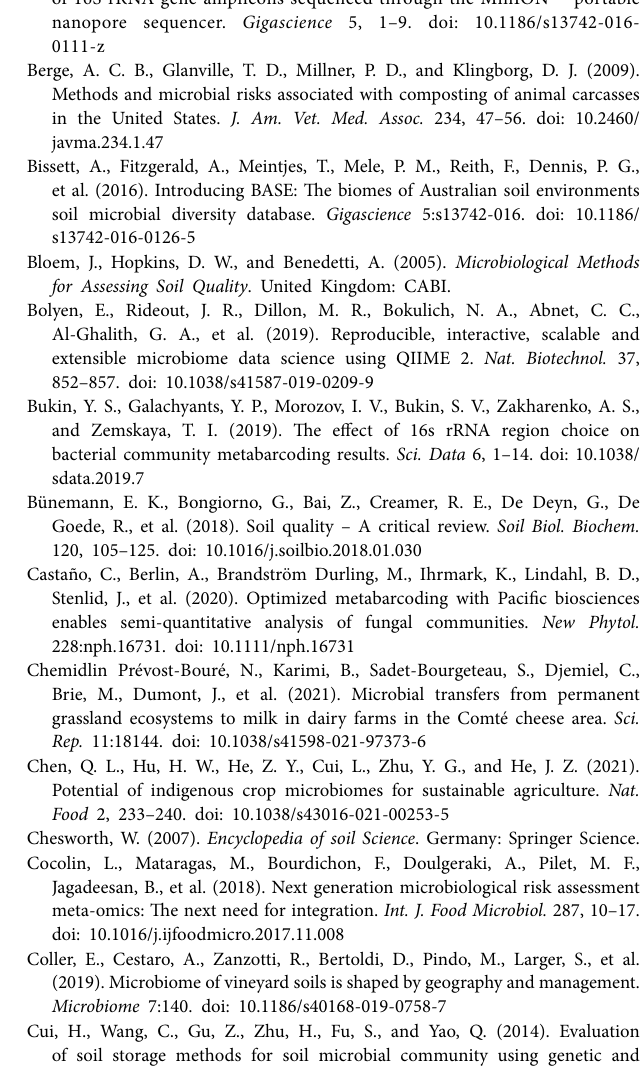
by agri-food industries, XXX: Adapted technique with a very good data / price ratio, XX: Adapted technique with a moderate data / price ratio, X: Adapted technique with a low data/price